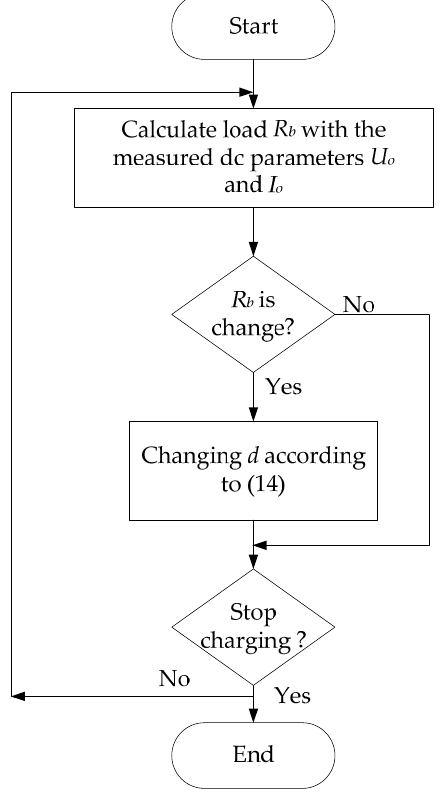
Figure 5. Flowchart of the maximum power transfer tracking.